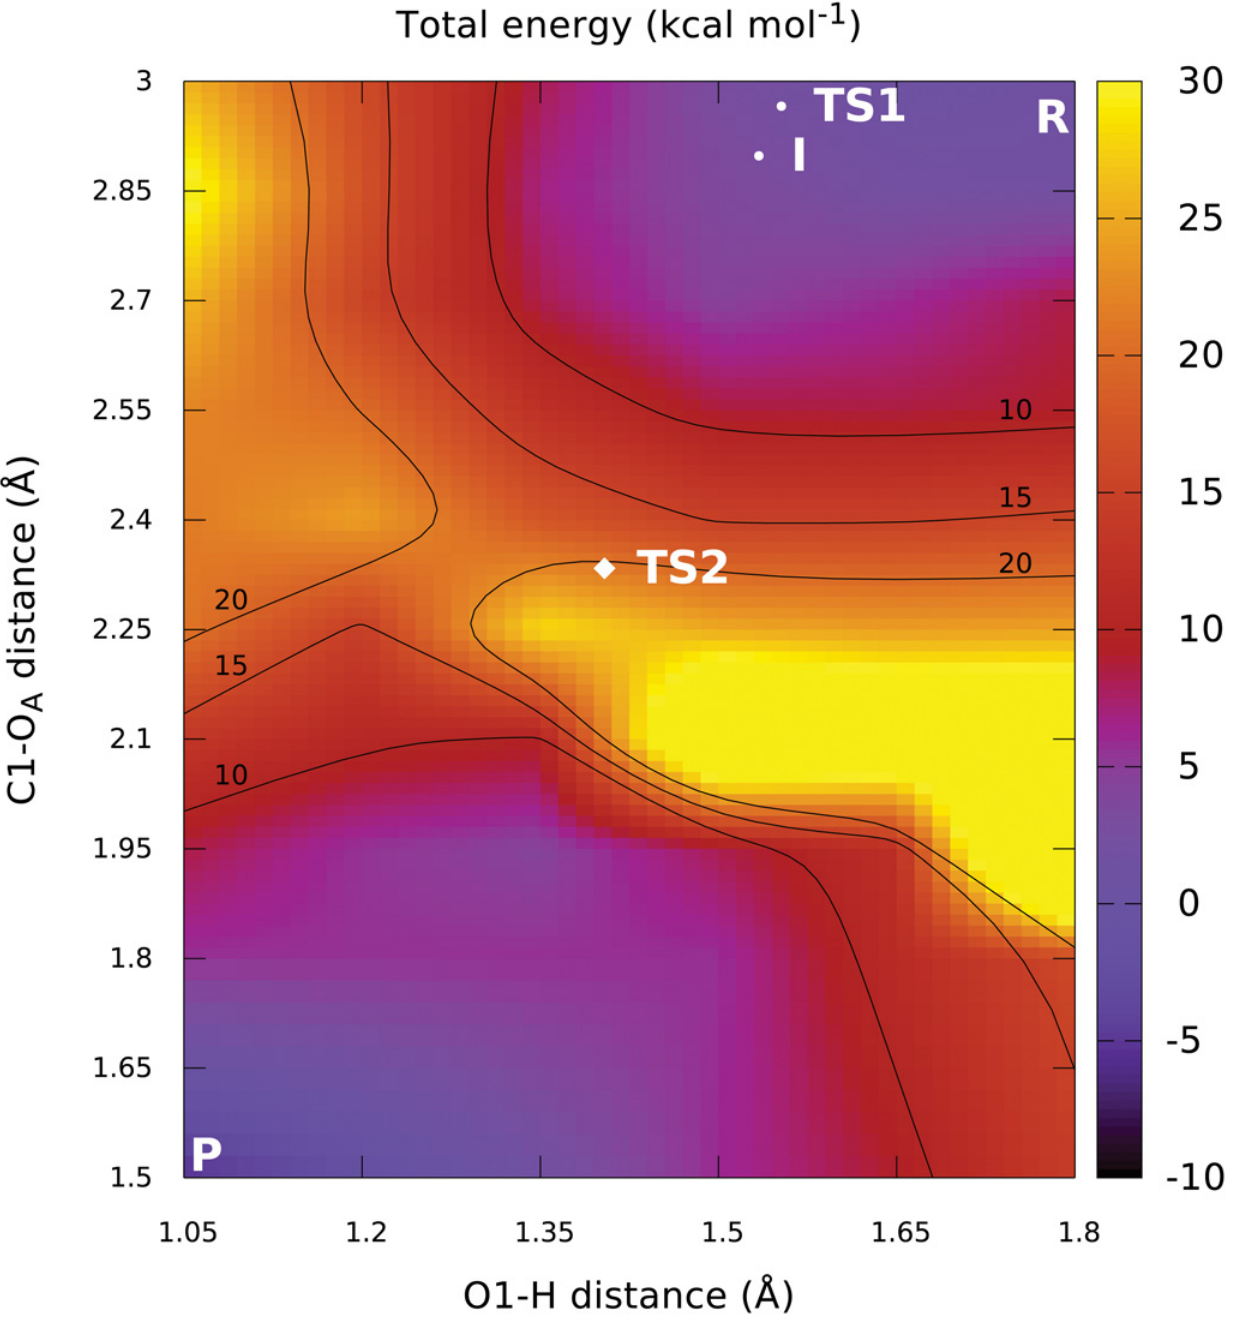
Fig 3. Flawed two-dimensional PES obtained by scanning distances. A serious but invisible discontinuity is present in the apparent barrier region. Additionally, the correct final projected positions of the transition states and the expected intermediate are shown for comparison.